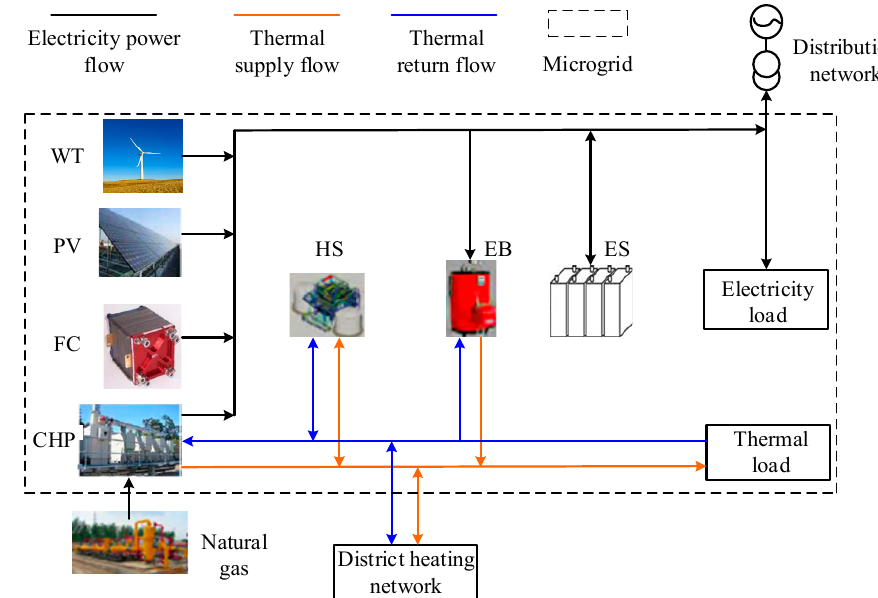
Figure 1. Structure and energy flow of CHP ‐ based MG system.